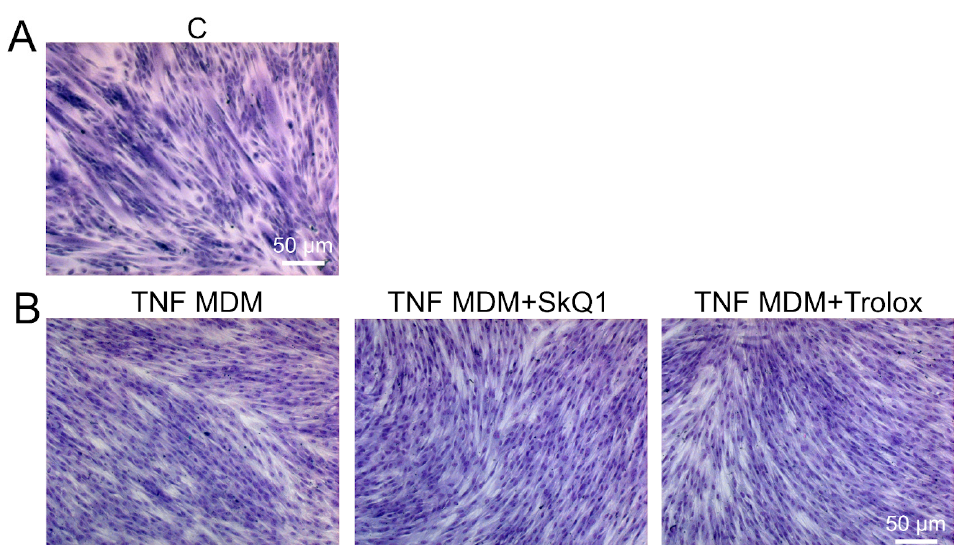
Figure A2. Antioxidants do not restore myogenesis disturbed by TNF added to differentiation medium (MDM). Myoblasts fusion was assessed on the 3rd day after differentiation induction using May–Grunwald staining. Representative images are shown, scale bar: 50 μ m. Control cells are shown in ( A ). ( B ) Antioxidants SkQ1 (40 nM) and Trolox (100 μ M) were added 72 h before differentiation induction and then again into the differentiation medium. TNF was added to the differentiation medium (MDM).